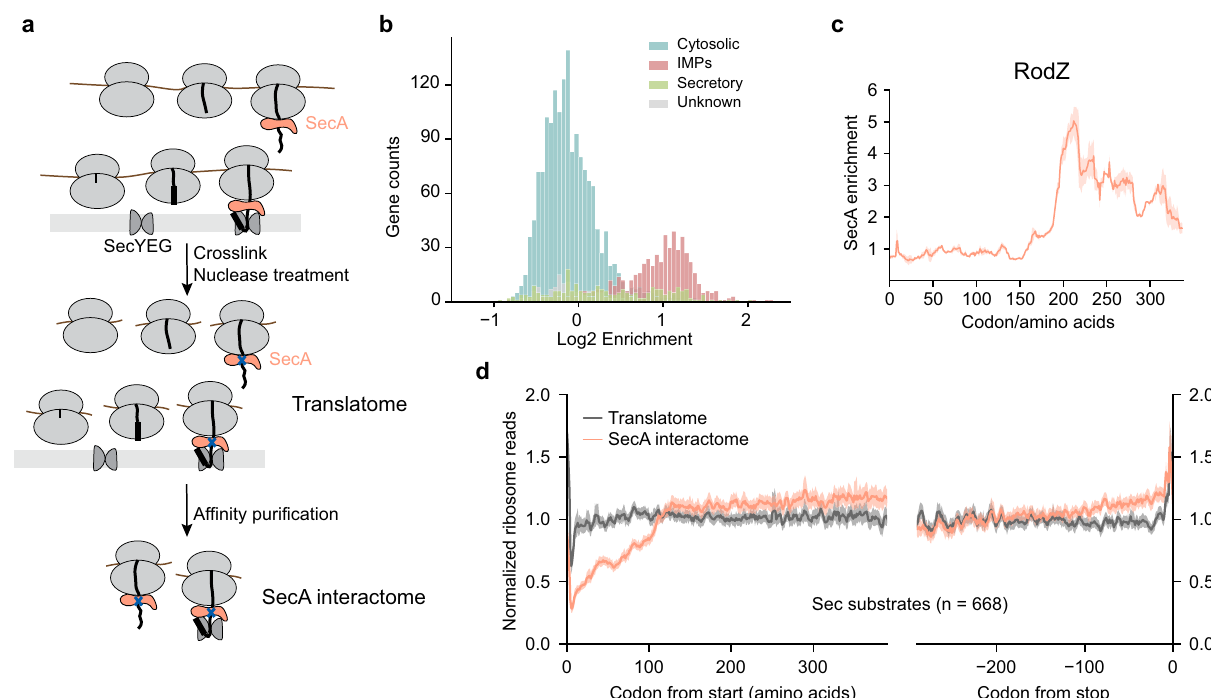
Fig. 1 Cotranslational engagement of SecA with RNCs. a Schematic of SeRP of SecA. Cells are harvested and cryogenically lysed, followed by crosslinking SecA-RNCs using EDC. Monosomes generated by nuclease digestion of polysomes are isolated by centrifugation through a sucrose cushion. SecA-RNCs are puri fi ed from total monosomes via the biotin moiety on Avi-tagged SecA and eluted by thrombin cleavage. Ribosome-protected fragments from the total ribosome population and from SecA-bound RNCs were extracted and sequenced, generating information on the translatome and SecA-interactome. b Distribution of SecA enrichment on all genes ( n = 2562) categorized by protein localization. c SecA interaction pro fi le of the RodZ nascent chain. The solid line shows the mean, and the shaded area shows the range of data from two independent biological replicates. d Metagene translatome and SecA interactome pro fi les of Sec substrates aligned to the start and stop codon. Solid lines show the mean values, and shaded areas show the 95% con fi dence interval